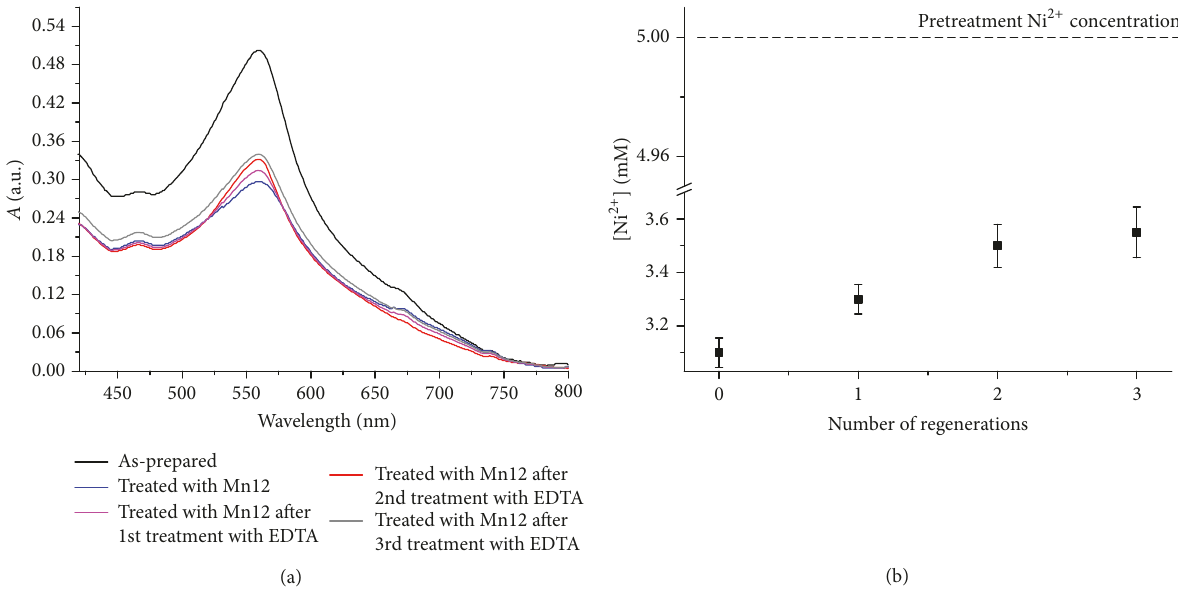
Figure 7: (a) Reusability of Mn12 nanostructure for Ni 2+ decontamination after EDTA treatments revealed by dimethylglyoxime test and (b) influence of the number of regenerations on the Ni 2+ removal.